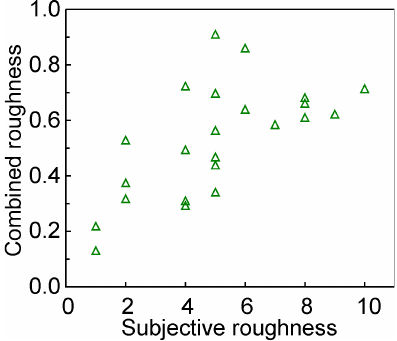
Fig. 4. Combined roughness measure of test particles plotted against subjective roughness (see Sect. 2). A wider range of particles than in Table 3 was tested. Fig. 5. Six randomly selected SID-3 patterns from ice particles seen during CONSTRAIN cirrus (top) and mixed-phase (bottom)